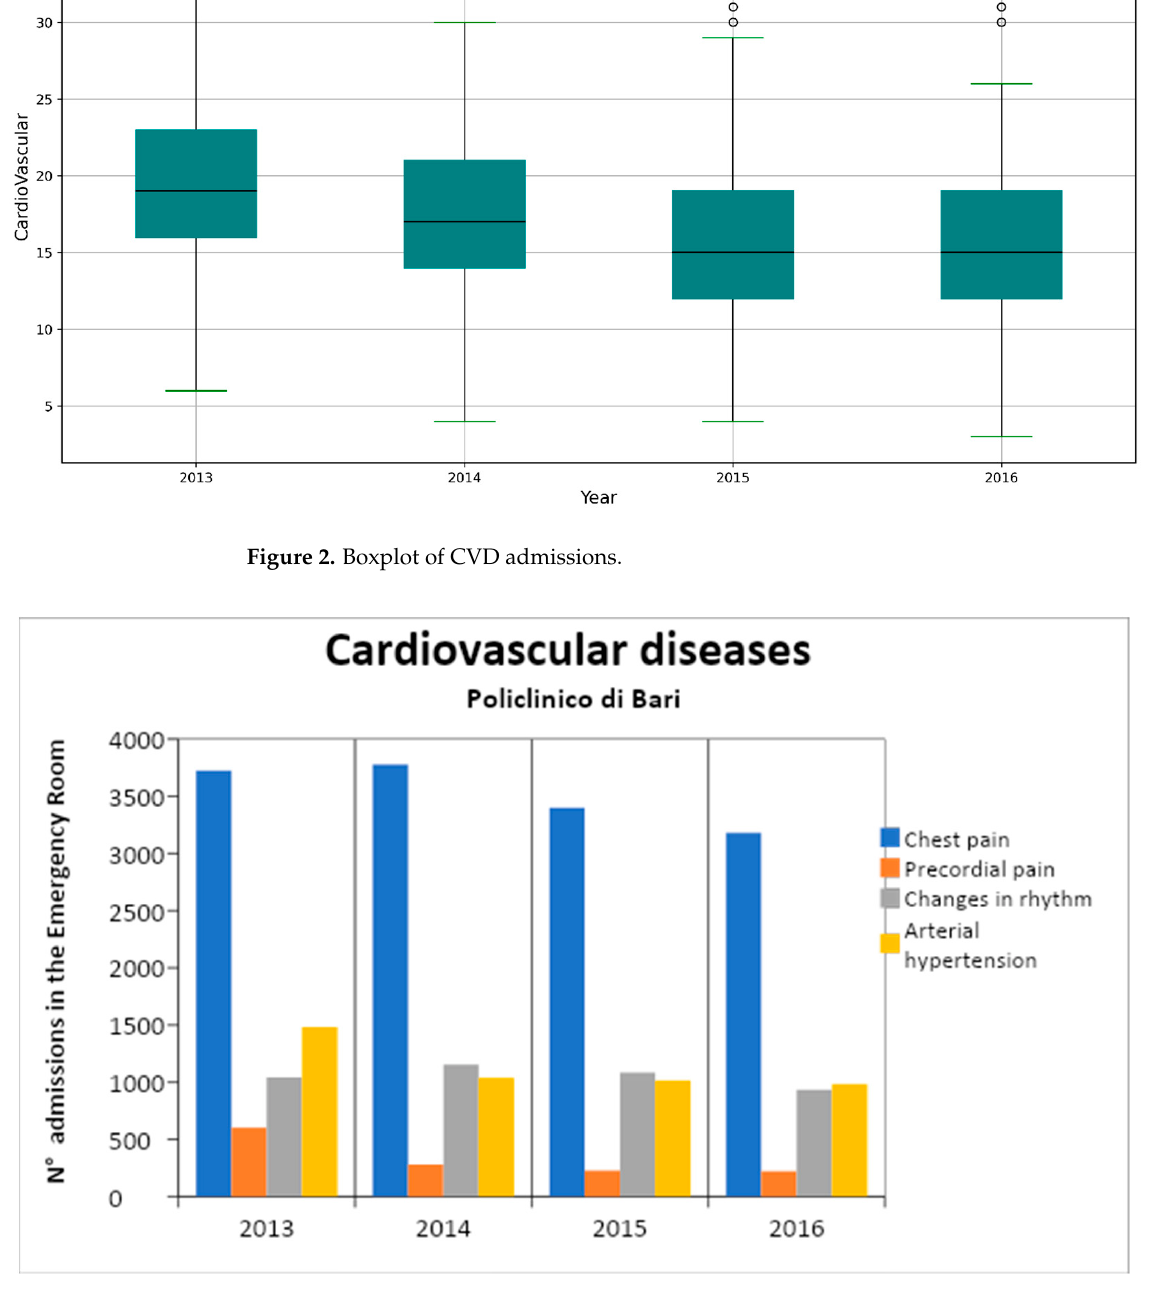
Figure 3. Annual admissions for CVD.